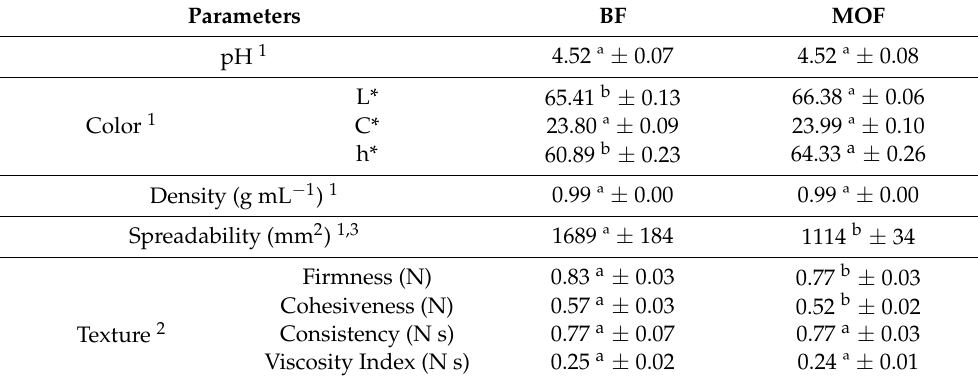
Table 4. Characterization of formulations: base (BF) and with microcapsules of coffee oil (MOF).